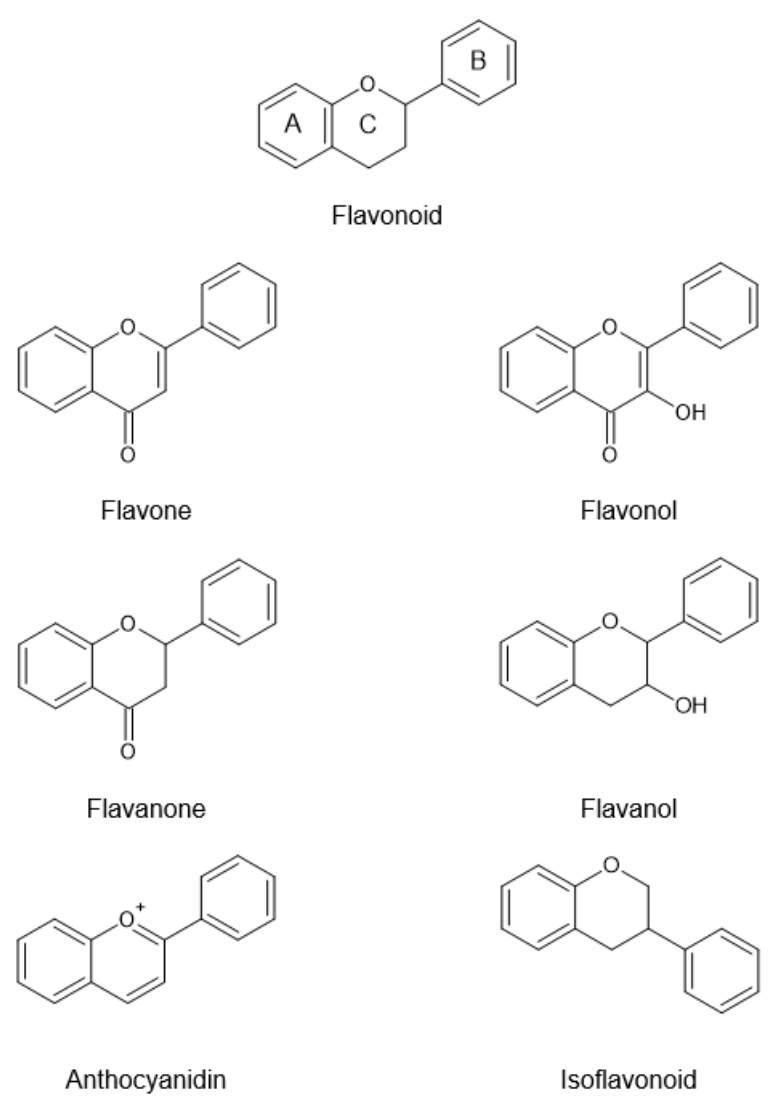
Figure 2. Subclasses of flavonoids.